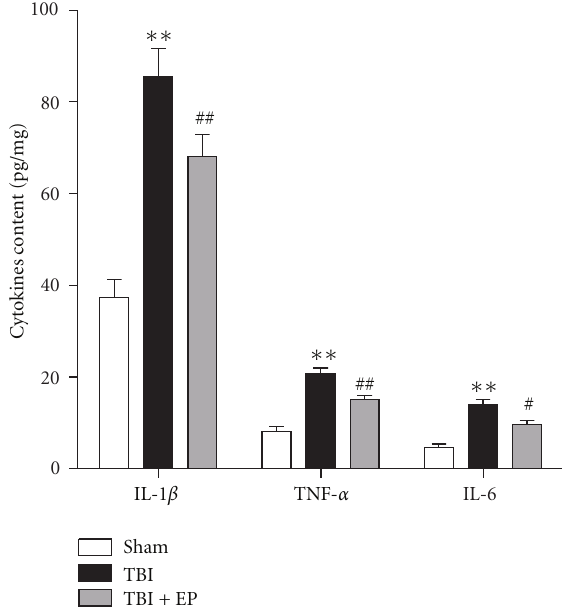
Figure 7: Changes of inflammatory mediators in the injured brain of rats determined by ELISA in Sham group, TBI group, and TBI + EP group. The figure indicated that the levels of TNF- α , IL-1 β , and IL-6 in the injured brain tissue were significantly increased after TBI. In the TBI + EP group, the concentrations of TNF- α , IL-1 β , and IL-6 were markedly downregulated when treated with EP. Bars represent as mean ± SEM; n = 6, each group; ∗∗ P < . 01 compared with Sham group, # P < . 05, ## P < . 01 compared with TBI